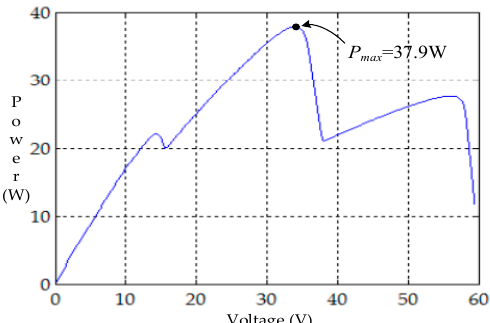
Figure 11. Simulation of P–V characteristic curve in Case 3.